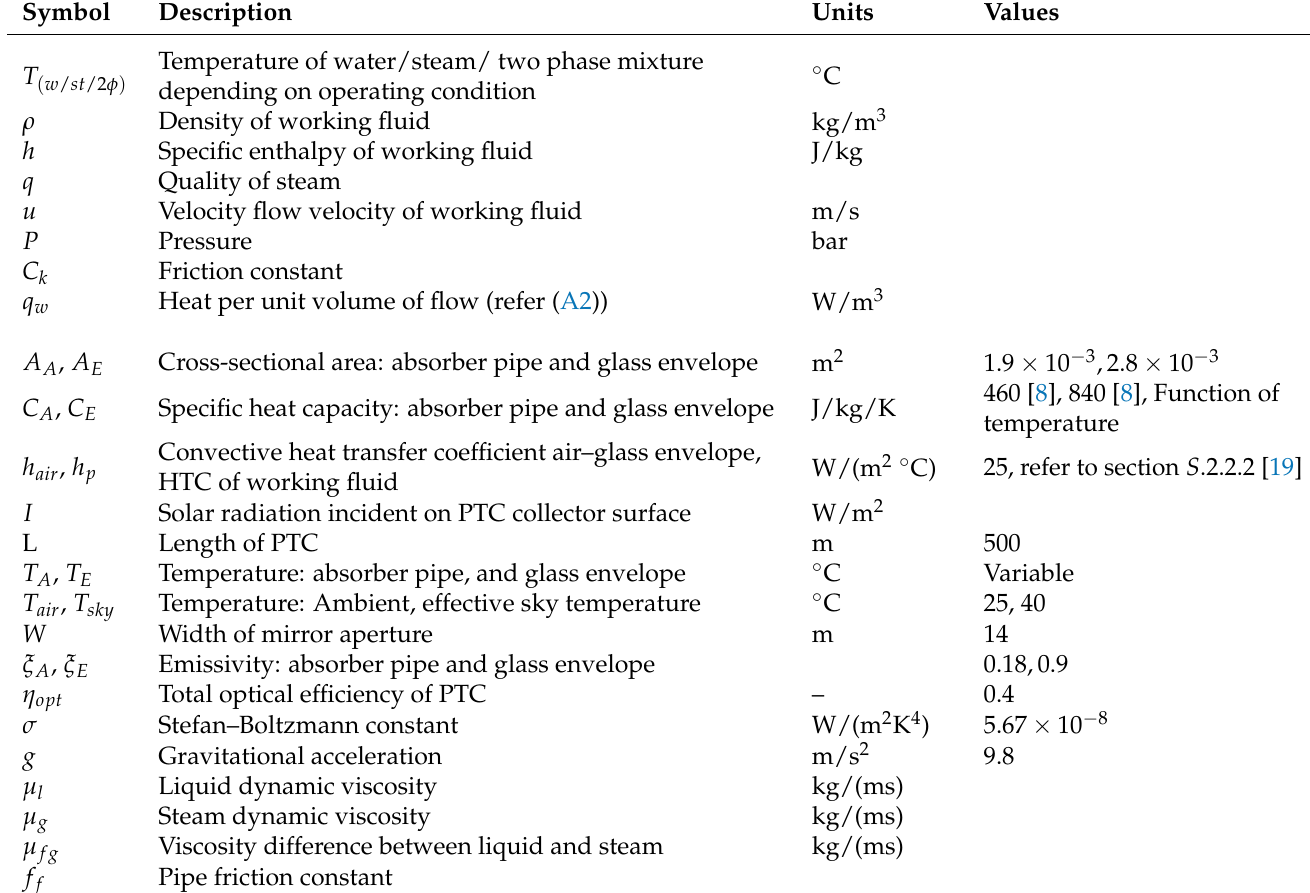
Table A1. LFR: notation and values of parameters (Equations (4) to